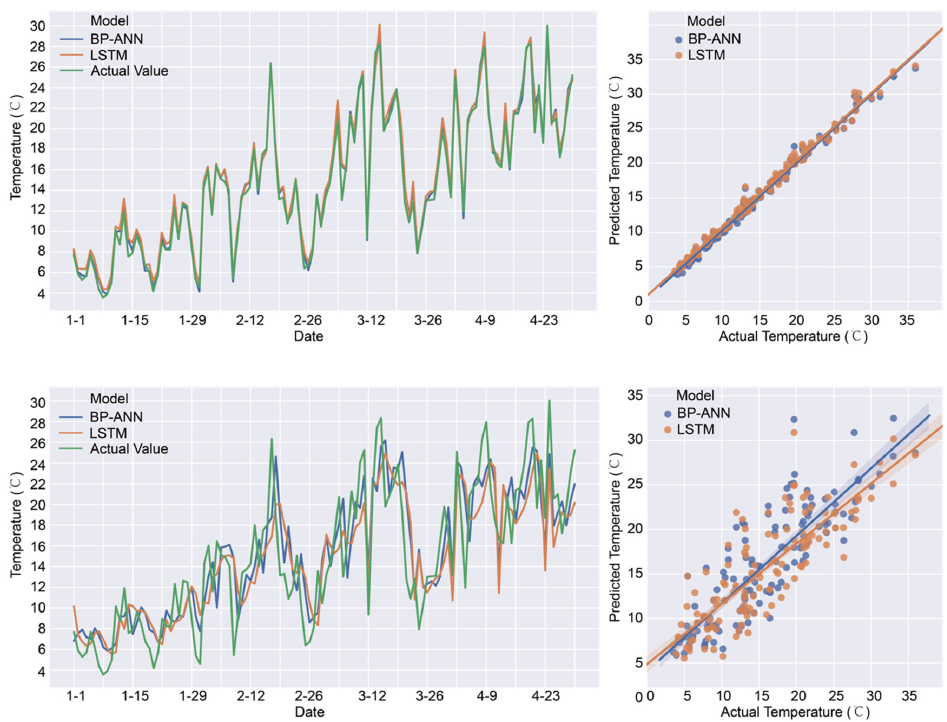
Figure 4. The prediction results of daily maximum temperature using BP-ANN and LSTM techniques in Model 1 ( up ) and 2 ( below ).